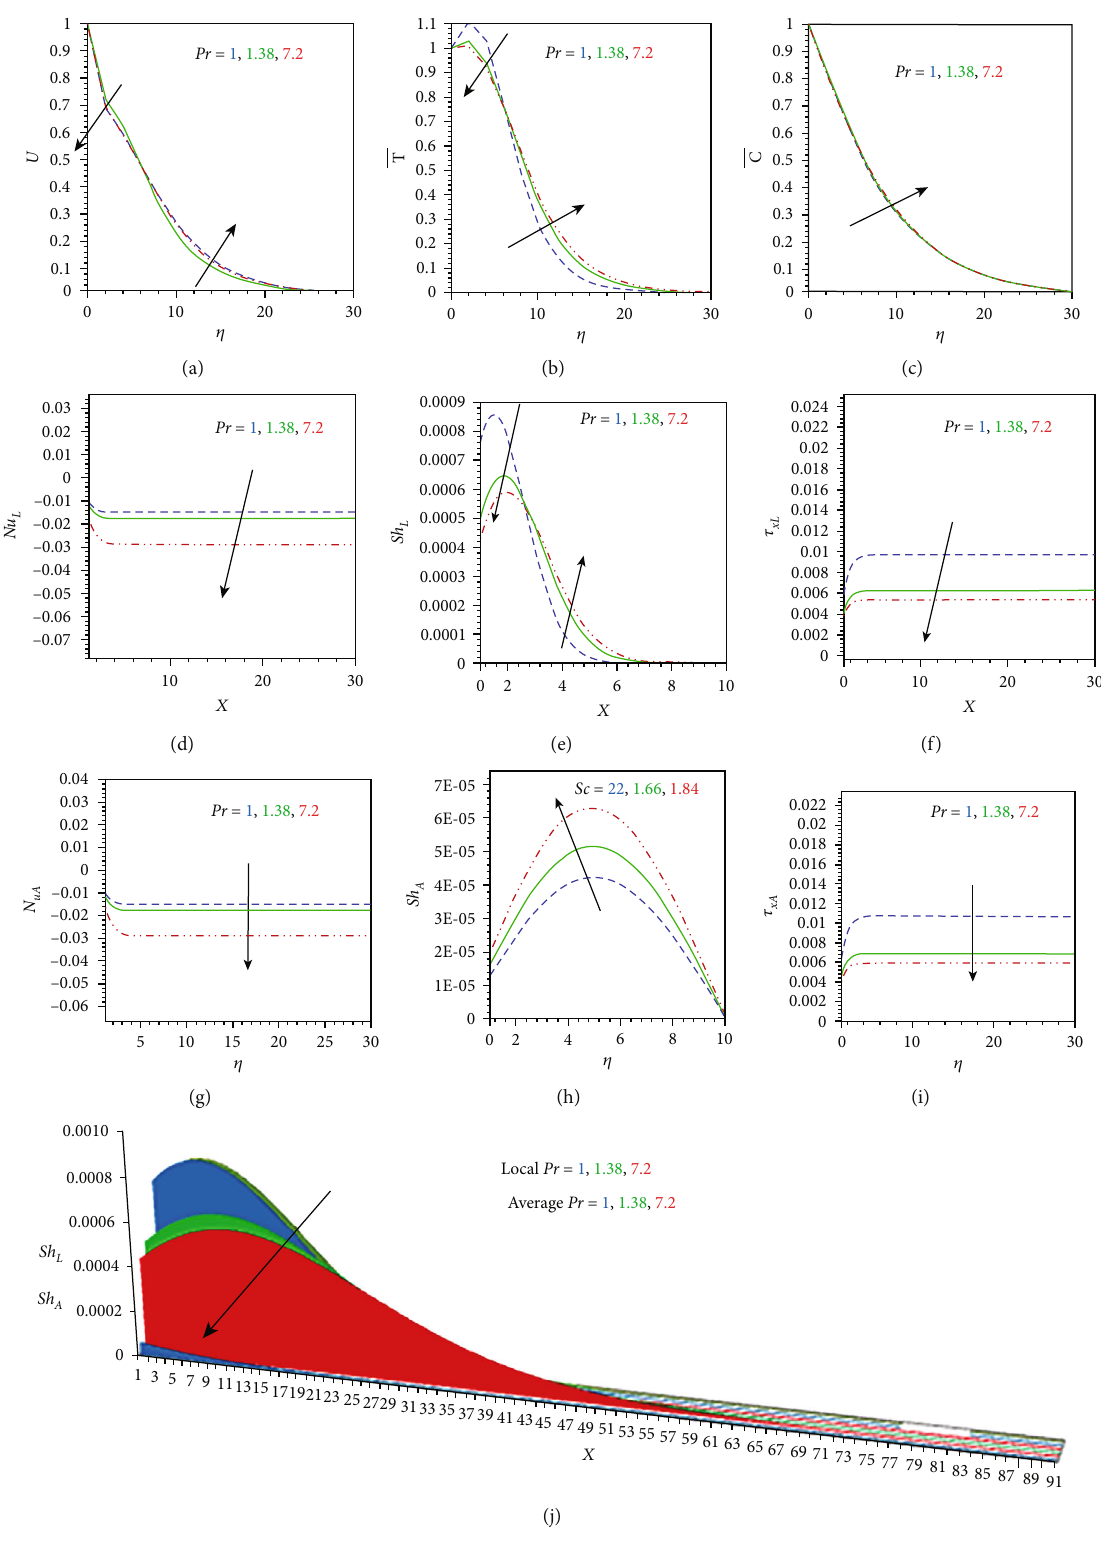
Figure 8: In fl uence of Prandtl number on (a) fl ow, (b) thermal, (c) material fi elds, (d) Nu and Sh comparatively in a 3D plot with M = 9 : 5 , Gr = 3 : 5 , Gm = 4 : 5 , Ec = 0 : 1 , Sc = 0 : 22 , N = 1 , R = 1 , and H = 0 : 3 and (j) Sh L A